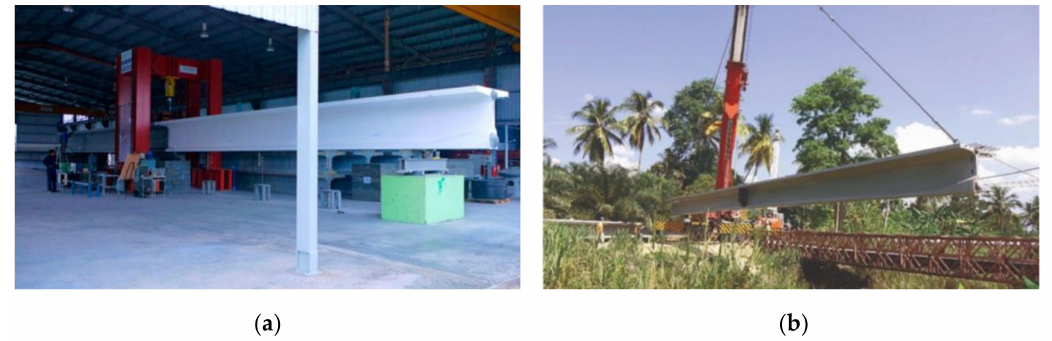
Figure 7. ( a ) Full-scale destructive test on a 30 m long segmental T-beam, research done